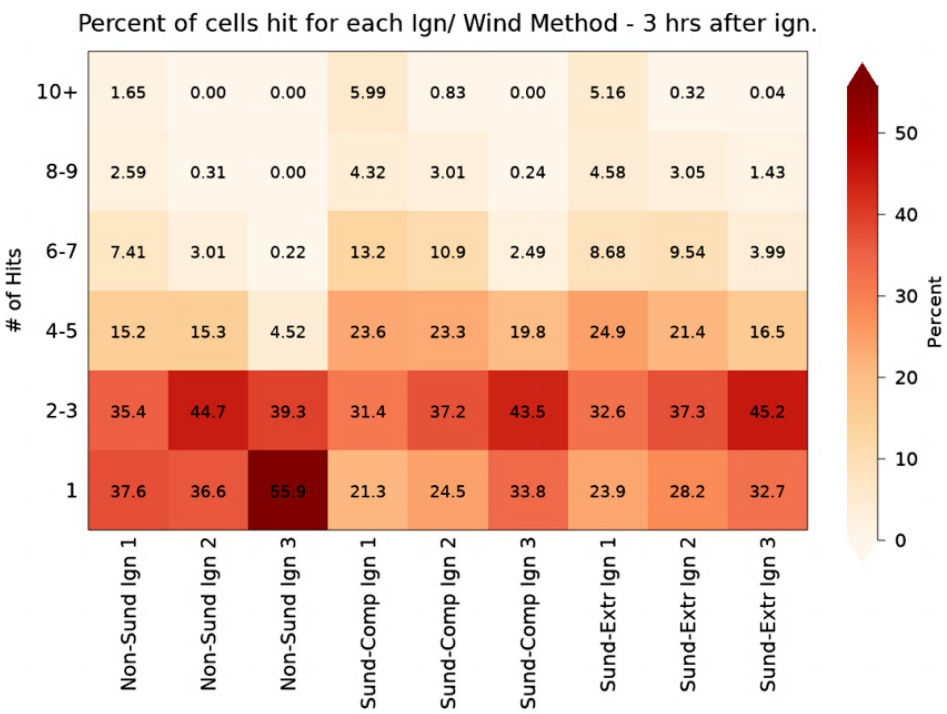
Figure 8. The percent of grid cells hit out for each “# of Hits” range considering the total number of grid cells hit for a particular ignition method/wind scenario combination.